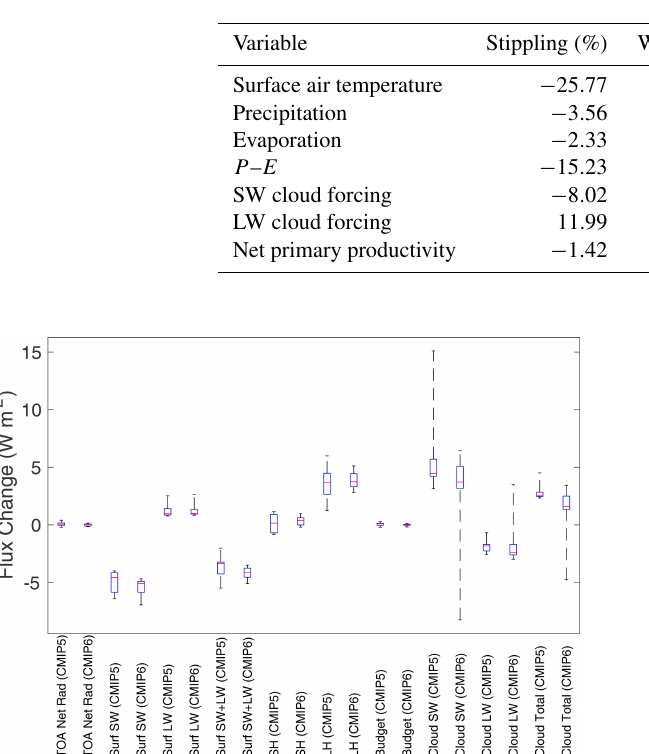
Table 3. Ensemble differences between the CMIP5 and CMIP6 ensembles for each variable evaluated in this study (left column). Column 2 indicates the difference between the ensembles in how much of the Earth’s surface is not stippled (more than 75% of models agree on the sign of the response; negative values indicate that CMIP6 has less unstippled area than CMIP5). Column 3 indicates the percent of the Earth’s surface for which the CMIP5 ensemble is statistically different from the CMIP6 ensemble, based on 95th percentile confidence intervals from Welch’s t test.